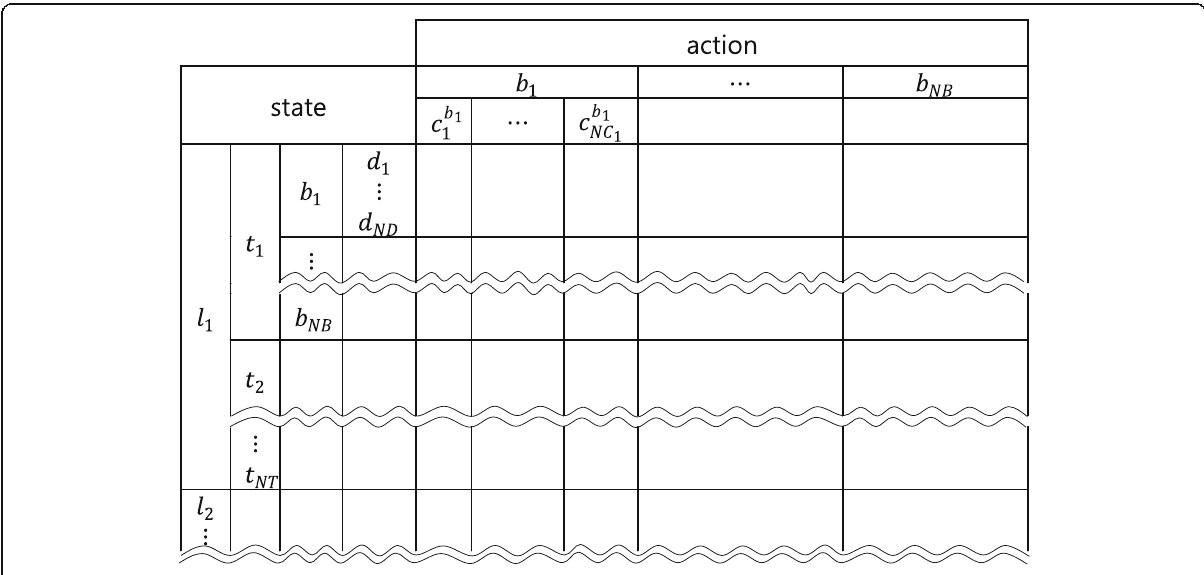
Fig. 5 Proposed Q-table structure. The column of the Q-table represents the action tuple of the band group b q ( q -th band group) and channel c b q m ( m -th channel of b q ). The row of the Q-table is the state tuple of the i -th geographic location zone ( l i ), j -th time zone ( t j ), k -th band group ( b k ), and l -th data rate efficiency level ( d